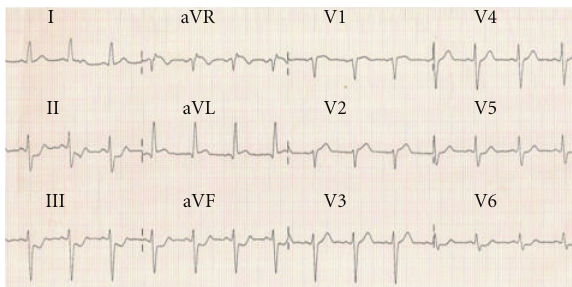
Figure 1: Presenting 12-lead electrocardiogram.